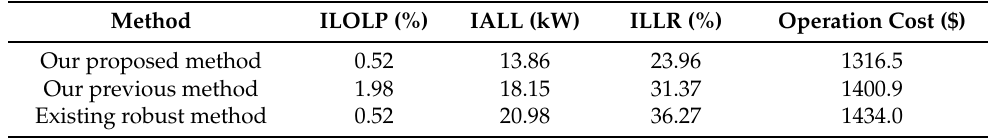
Table 3. Average performances of different